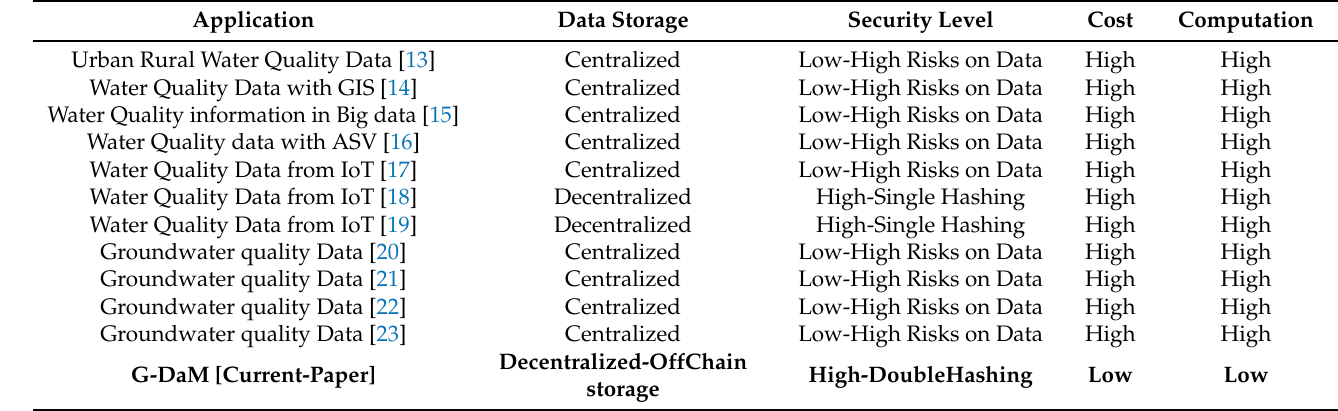
Table 1. Data management and storage approaches for water